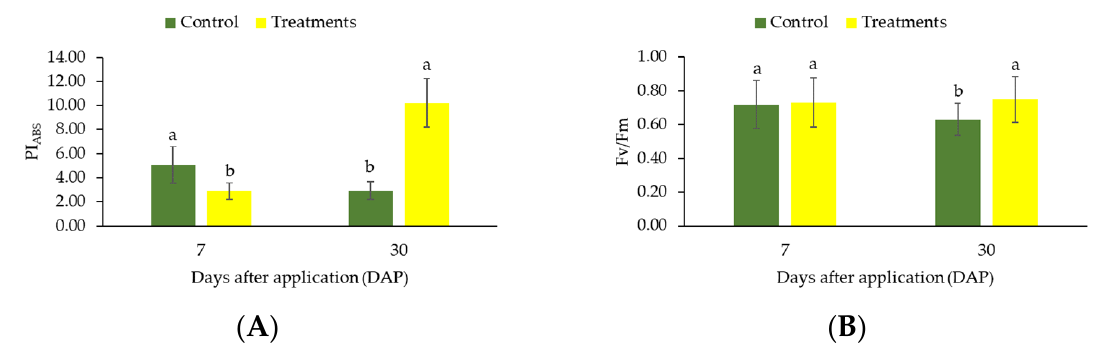
Figure 5. Changes in PIABS ( A ) values and Fv/Fm ratio ( B ) in coffee leaves (genotype “153”) submitted to high light after application of CC. The measurements were made after 7 and 30 days of treatment. Before the measurements, leaves were dark-adapted for 30 min. Values are averages for eight plants. The data shows mean value ± standard errors. Averages followed by different lowercase letters in each sampling (7 and 30 days) differ by Tukey’s test, at 5% probability.